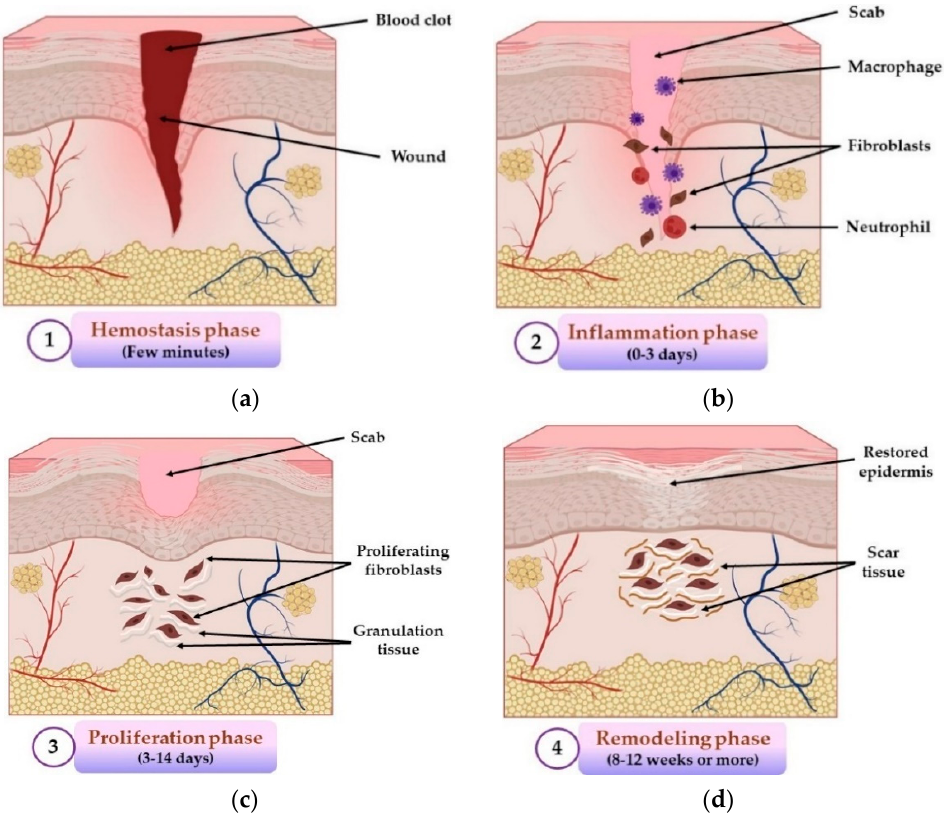
Figure 1. The four stages of wound healing process: ( a ) hemostasis phase; ( b ) inflammation phase; ( c ) proliferation phase; ( d ) remodeling phase. All illustrations have been created with BioRender.com, Inkscape, and PowerPoint.